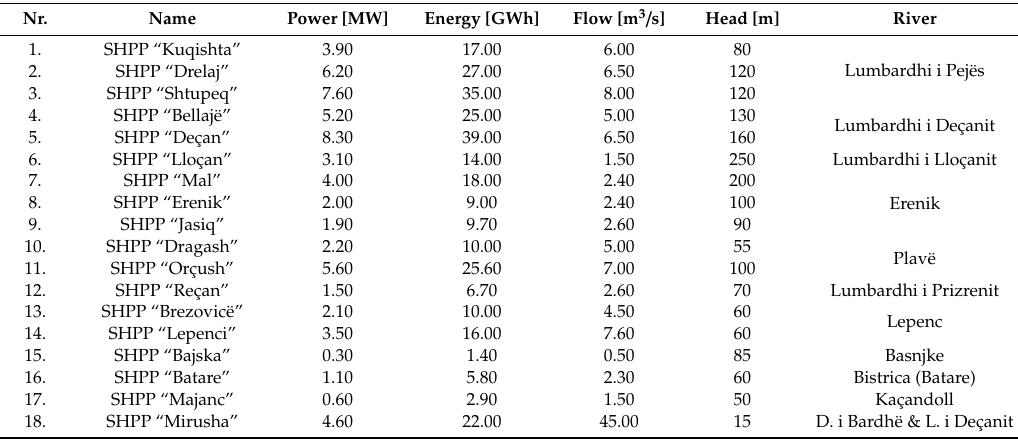
Table 6. Hydro energetic potential of rivers in Kosovo